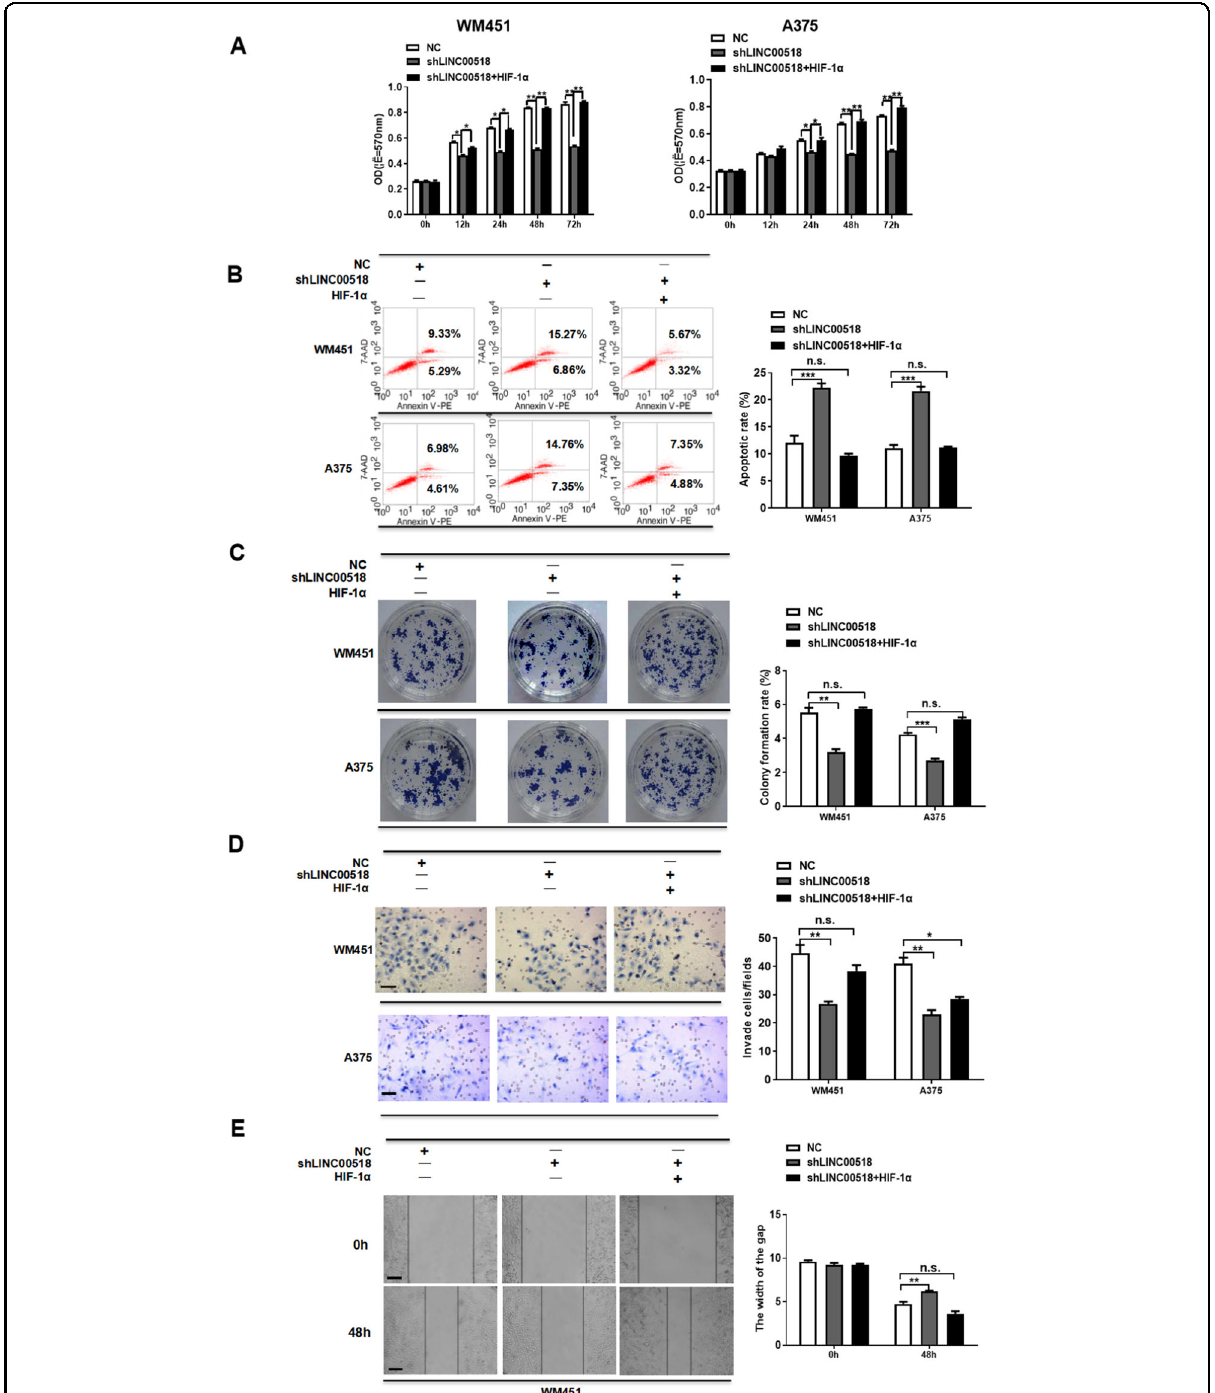
Fig. 5 Overexpression of HIF-1 α reversed LINC00518 knockdown-induced suppressing of proliferation, migration, invasion, and colony formation. A WM451 and A375 cells were transfected with NC, shLINC00518, shLINC00518 plus HIF-1 α overexpression plasmid; the MTT method was used to detect cell proliferation. B The effects of LINC00518 knockdown or LINC00518 knockdown plus HIF-1 α overexpression on apoptosis of WM451 or A375 cells were assessed using annexin V staining and fl ow cytometry analysis. C Colony formation assay showed that LINC00518 silenced is involved in signi fi cantly decreasing cell proliferation, HIF-1 α overexpression could reverse the regulatory effects of LINC00518 . D Invasion of melanoma cells in different transfection groups was assessed by the transwell assay. E Wound-healing assay was used to assess the migration of melanoma cells in different transfection groups. The histogram data for each group are an average of three independent replicates; bars indicate SD; * P < 0.05, ** P < 0.01, *** P <